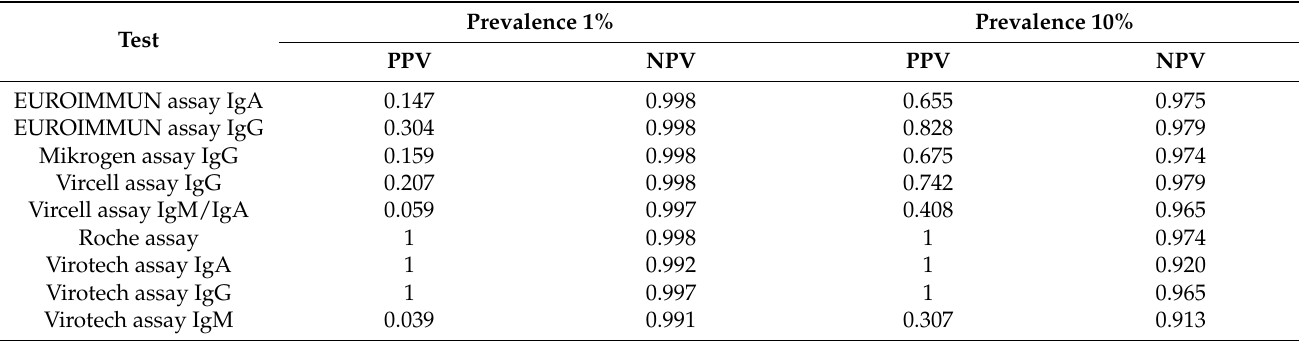
Table 5. Positive and negative predictive values * as calculated for two exemplary populations with 1% and 10% preva- lence,